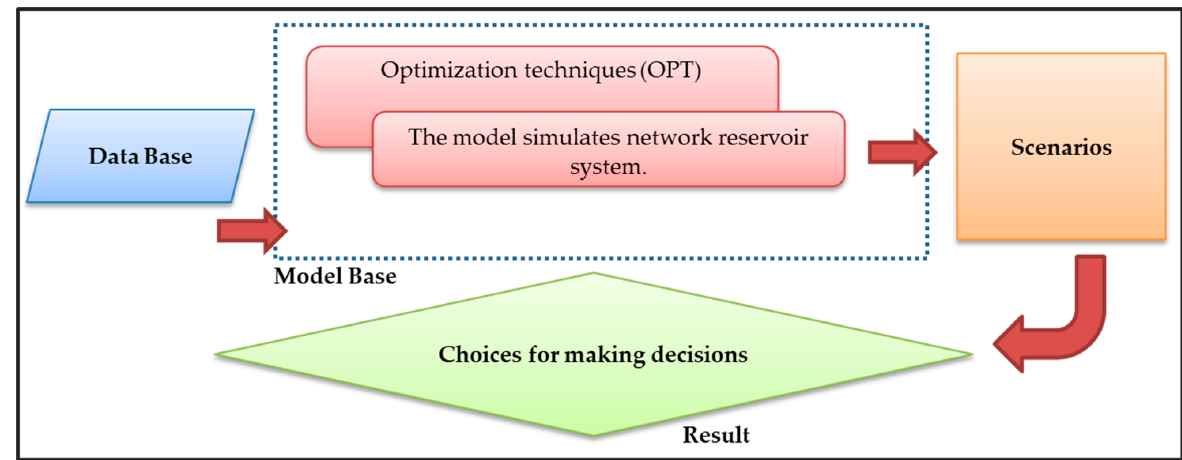
Figure 4. The process of making a network reservoir decision support system.